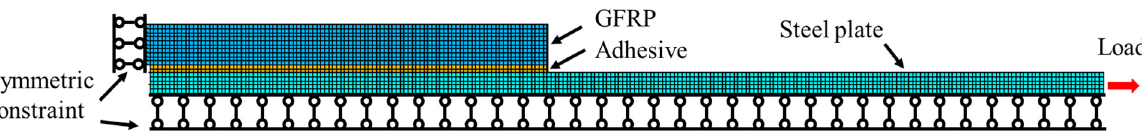
Figure 3. Finite element model of GFRP–steel bonded joint.